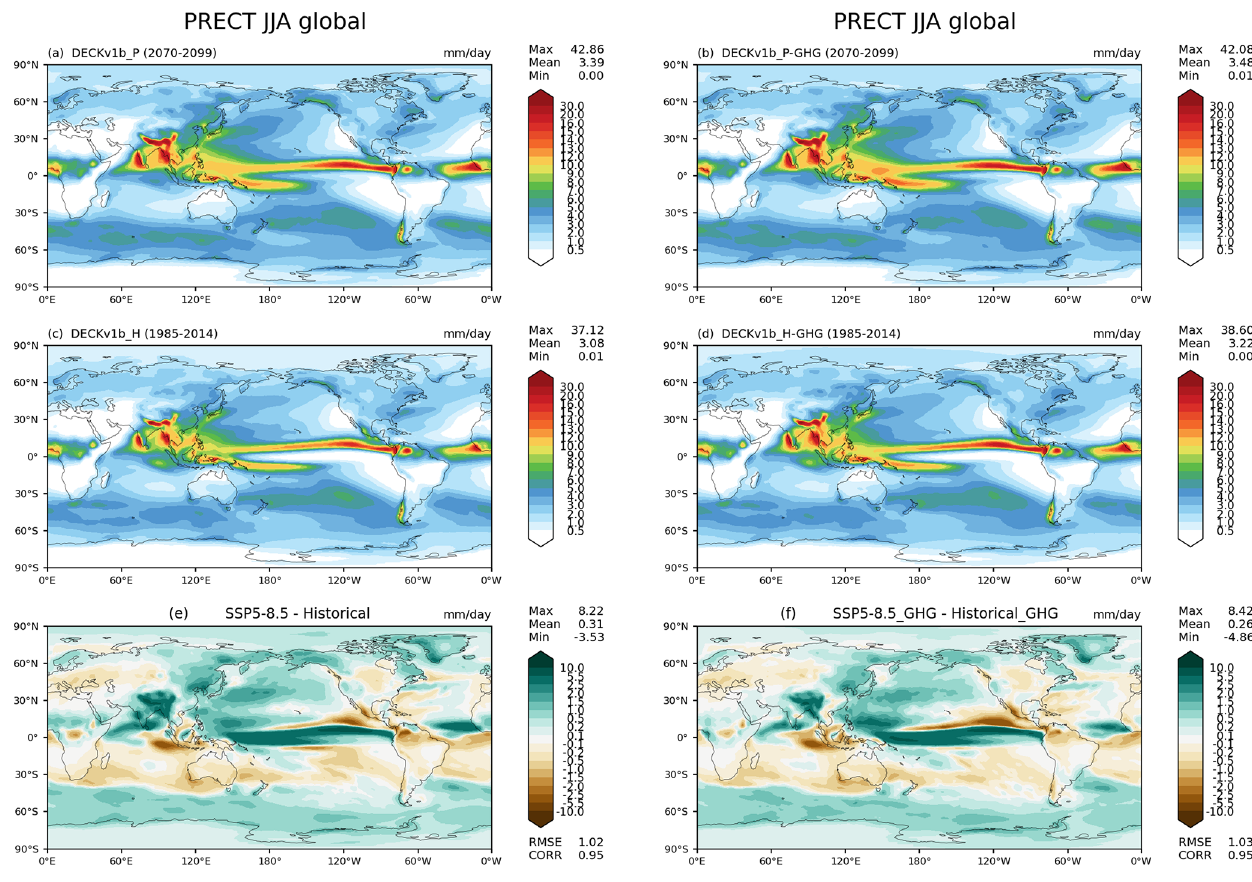
Figure A2. JJA mean precipitation rate (mmd − 1 ) from (a) five SSP5.85 ensemble simulations (2070–2099), (c) five historical ensemble simulations (1985–2014), and (e) the change between the time period of 2070–2099 and the period of 1985–2014. JJA mean precipitation rate (mmd − 1 ) from (b) three SSP5.85-GHG ensemble simulations (2070–2099), (d) three historical-GHG ensemble simulations (1985– 2014), and (f) the change between the time period of 2070–2099 and the period of 1985–2014.